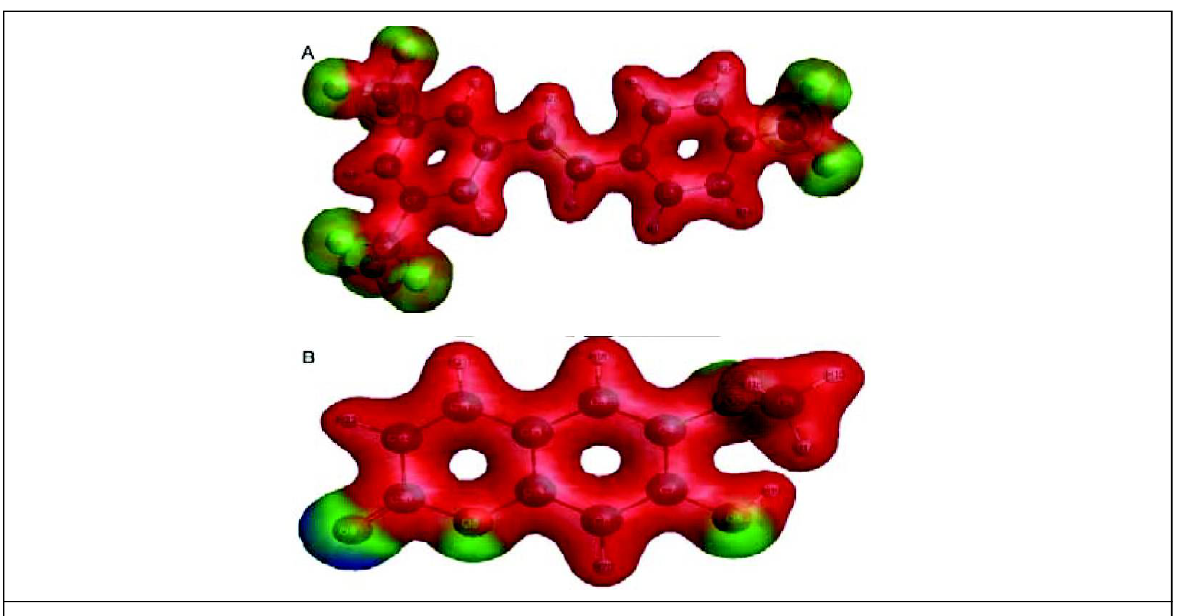
Figure 4: The color-coded contour maps illustrating the molecular electrostatic potential, the red color depicts electropositive centers, the blue regions represent the neutral potentials, and the green areas represent the electronegative centers: (A) Resveratrol derivative-R4; (B) Scopoletin derivative-S1